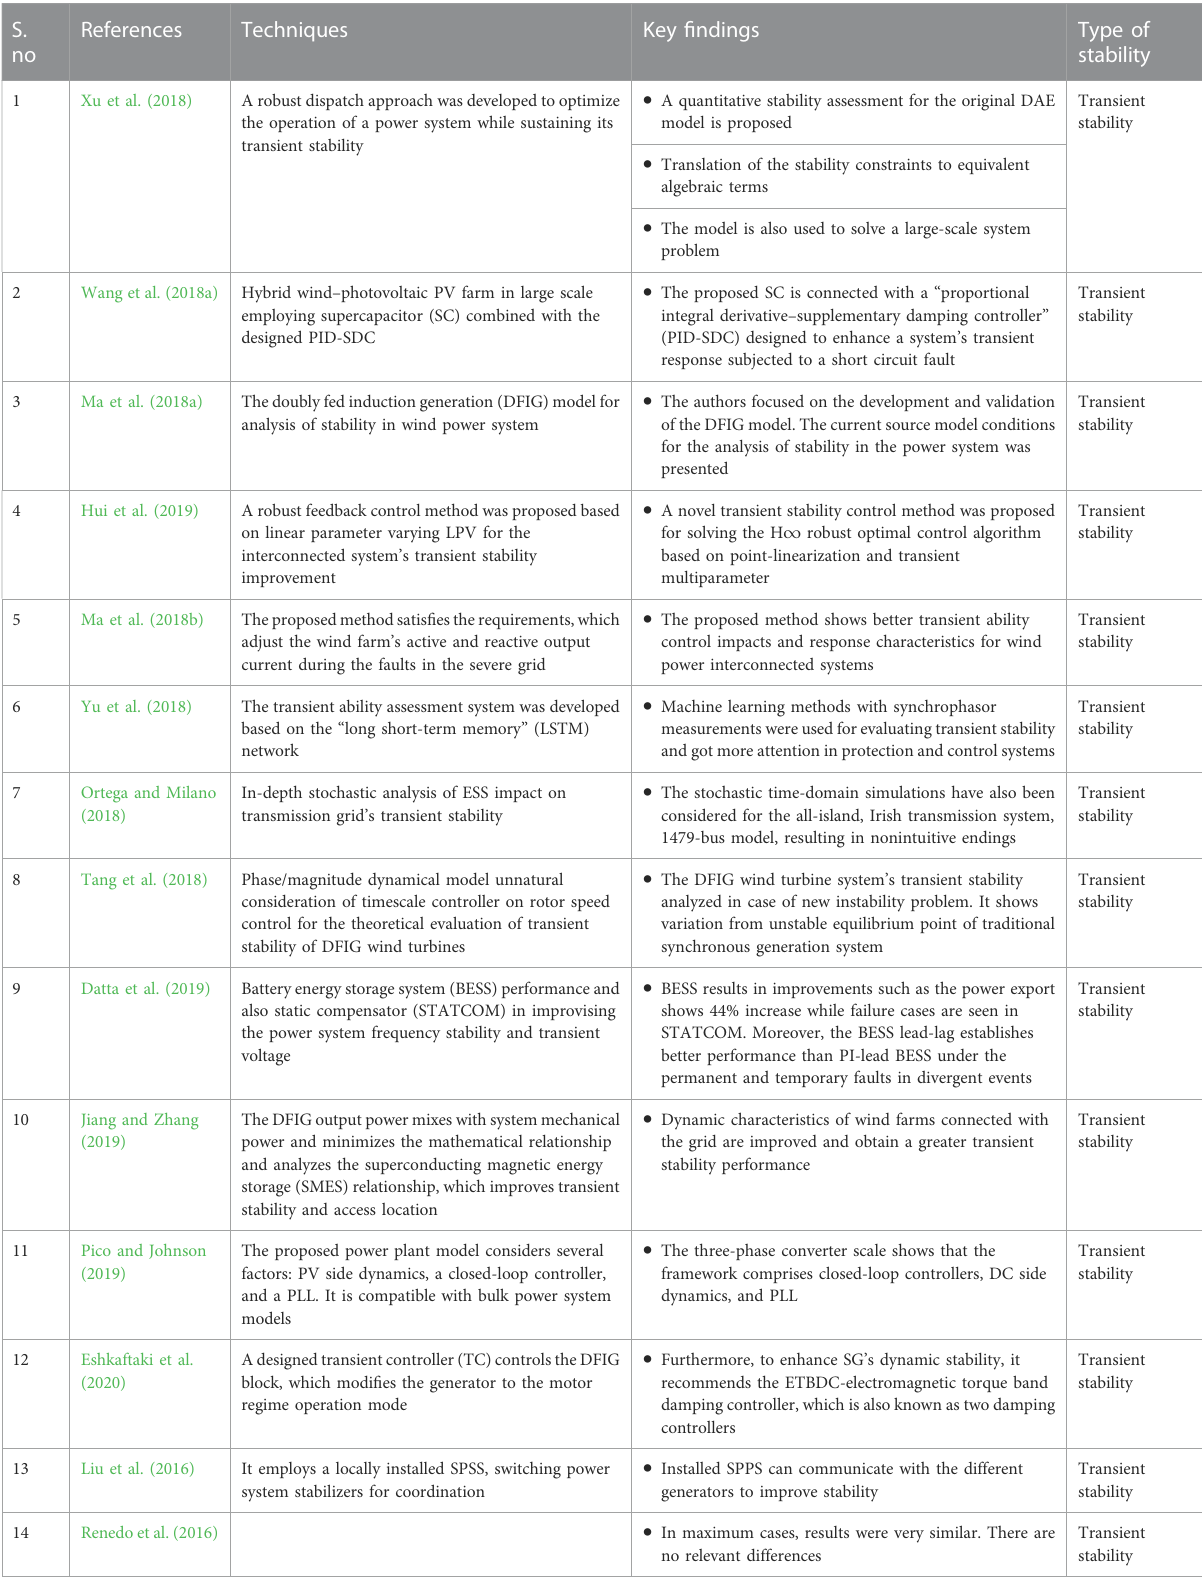
TABLE 1 Comparison of types of stability with the various existing research